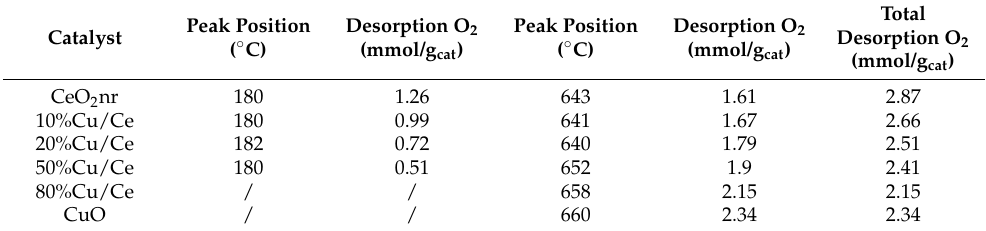
Table 3. The amounts of O 2 desorbed by O 2 -TPD from as-prepared catalyst samples. Catalyst